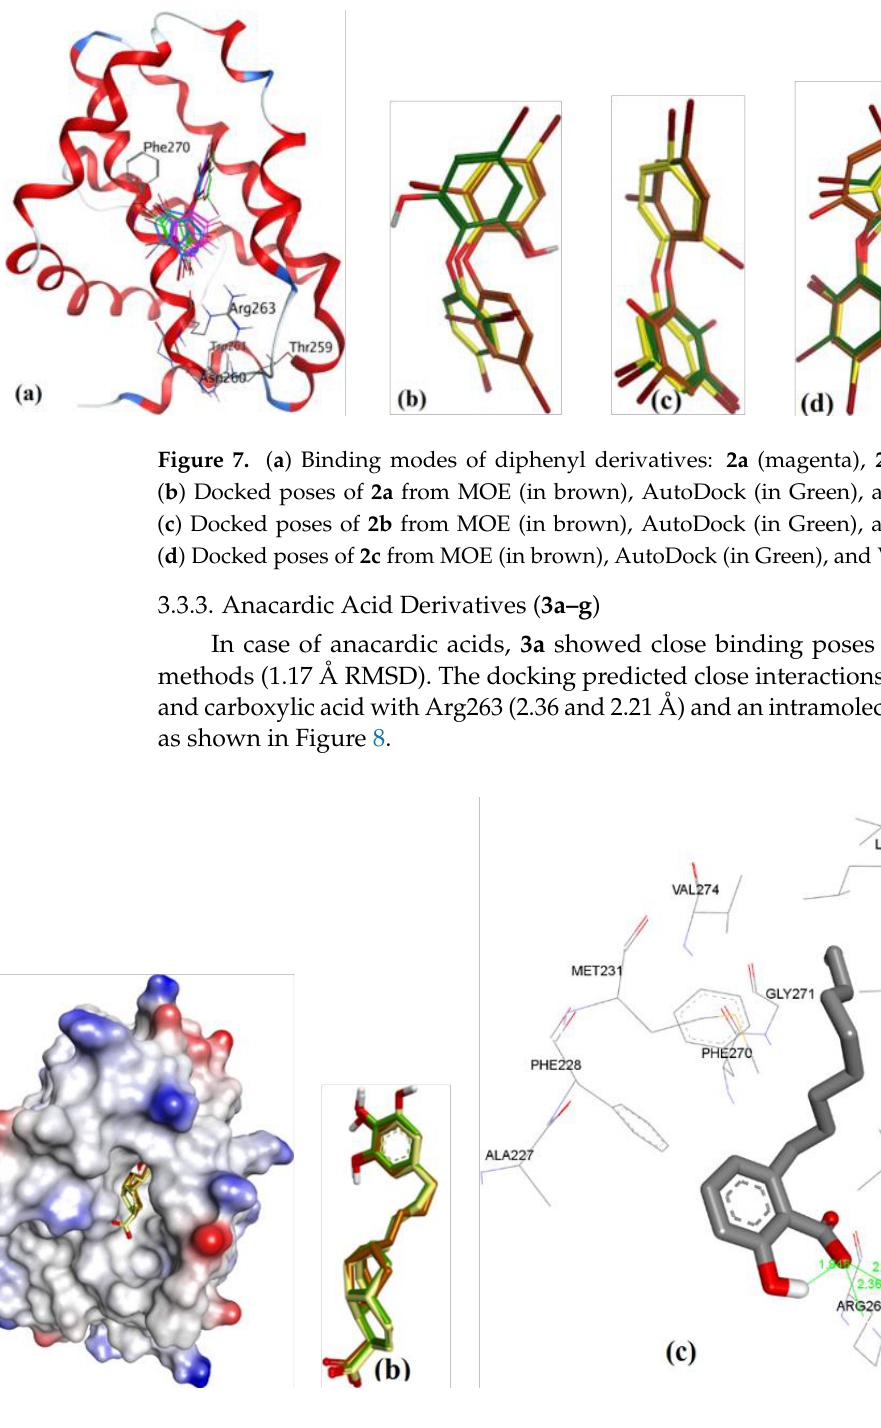
11 Figure 6. ( a ) The ionized solvent-exposed surface mapping of hMcl-1 along with the docked poses of Gymnochrome-F from MOE (in brown), AutoDock (in green), and VlifeDock (in yellow) show their fitting to the cavity, and all are within 1.08 Å RMSD. ( b ) Similar-pose ensemble clustering of all three poses was attained from the three different docking methods. ( c ) Binding mode of Gymno- chrome-F with hMcl-1. 3.3.2. Sponge-Derived Oxy-Polyhalogenated Diphenyl Ethers 2